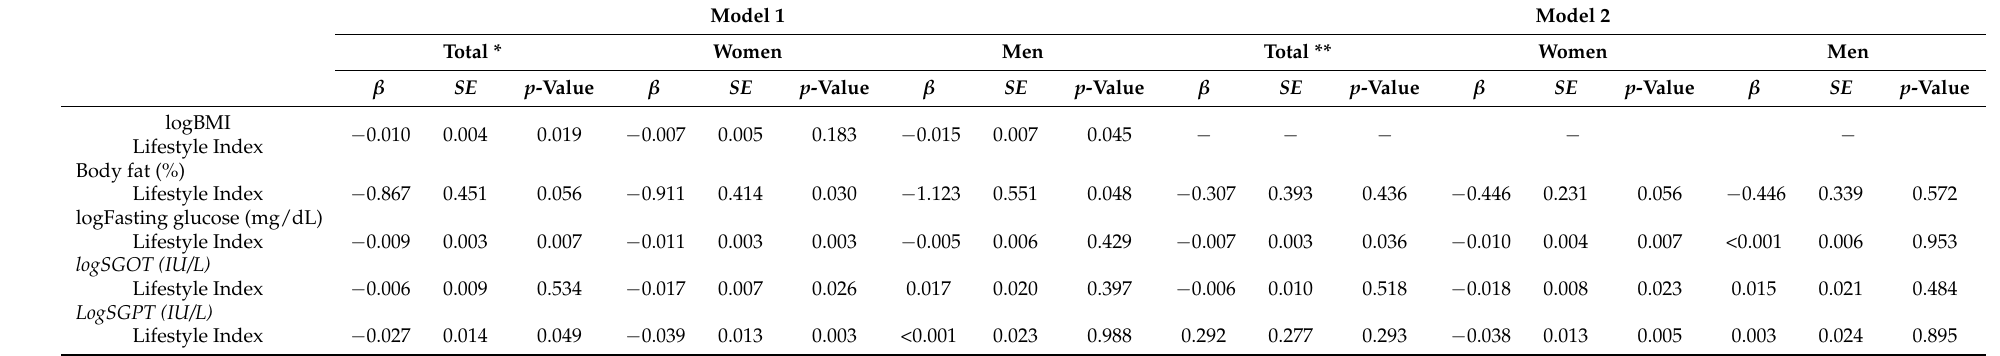
Table 6. Multivariate linear regressions between anthropometric and clinical characteristics and the constructed lifestyle index. Model